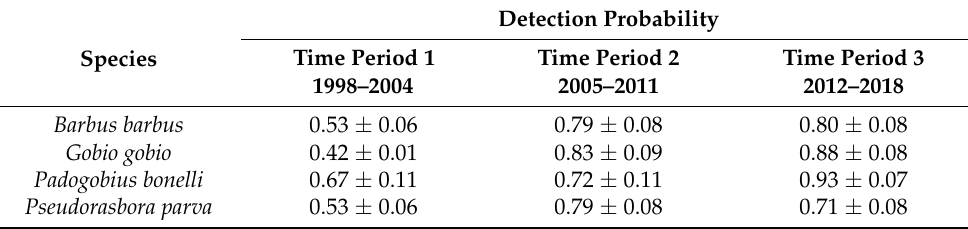
Table 3. Probability of detection ( ± standard error (SE)) across the four time periods for Barbus barbus , Gobio gobio , Padogobius bonelli and Pseudorasbora parva Table 2. Overall occupancy ( ψ ), colonization ( ɣ ), extirpation ( ε ) and detection (p) probabilities (±SE) for Barbus barbus , Gobio gobio , Padogobius bonelli and Pseudorasbora parva .